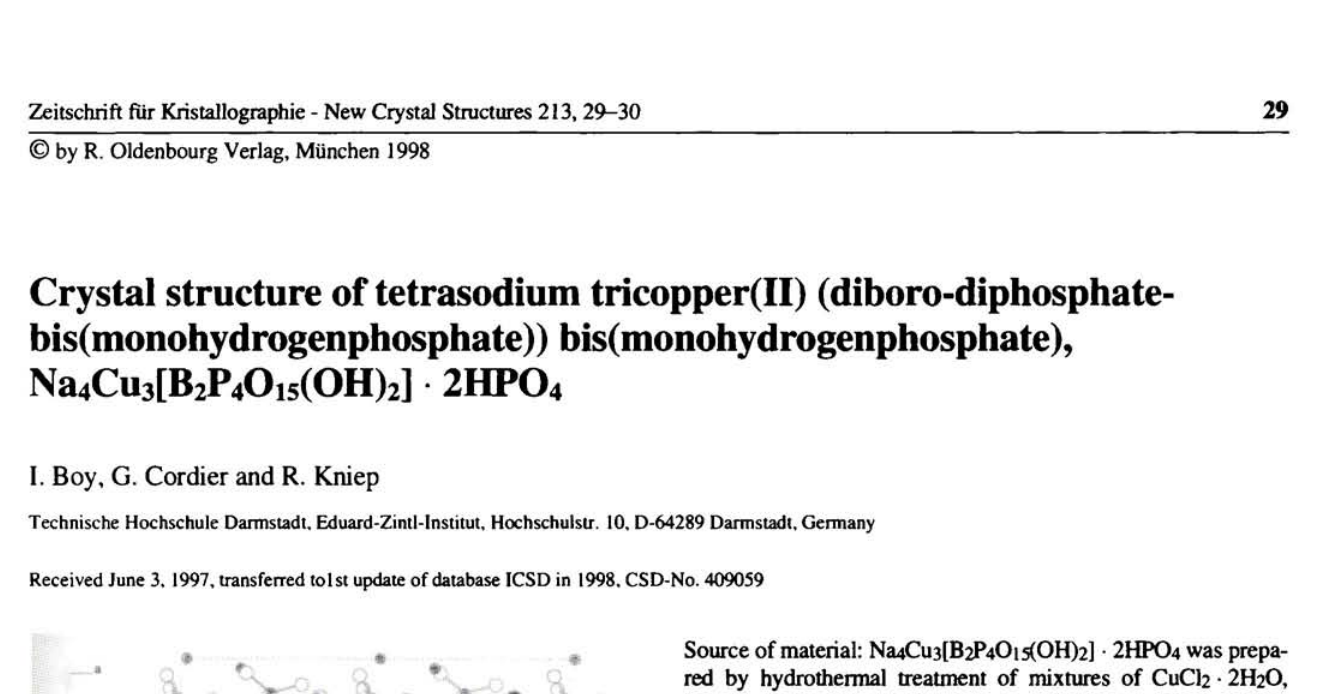
Table 1. Parameters used for the X-ray data collection Crystal: